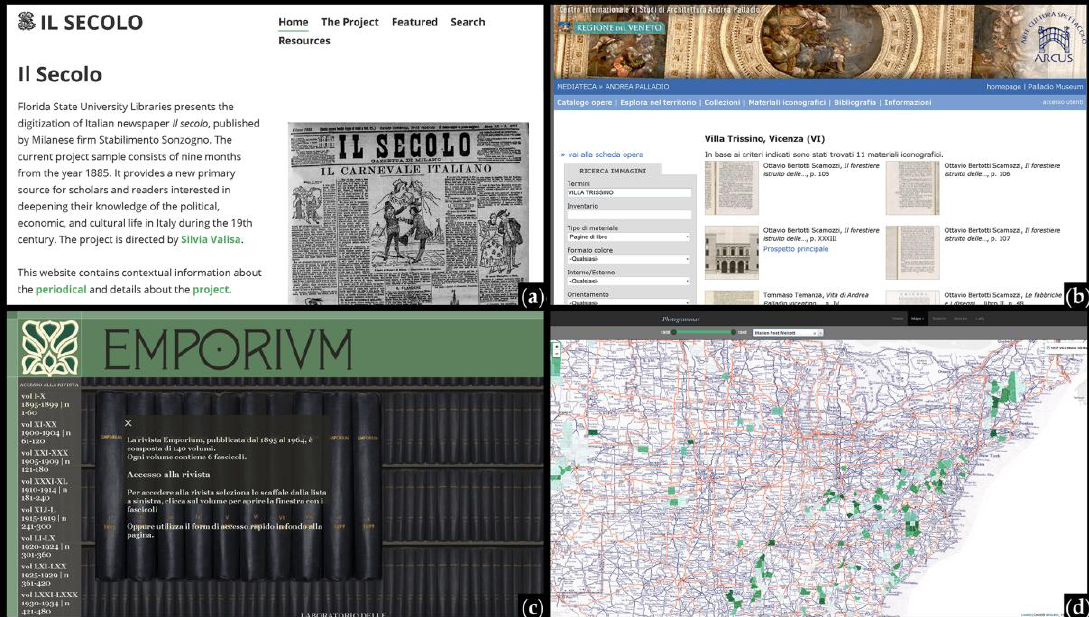
Figure 1. ( a ) Progetto Sonzogno , sample of the digitization of Italian newspaper Il Secolo (year 1885), edited by Sonzogno Publishing House; ( b ) PALLADIOLibrary Mediateca ; ( c ) La fototeca di Emporium , online digitalization of the whole Emporium magazine; ( d ) Photogrammar , project of digitalization and dissemination of the FSA-OWI